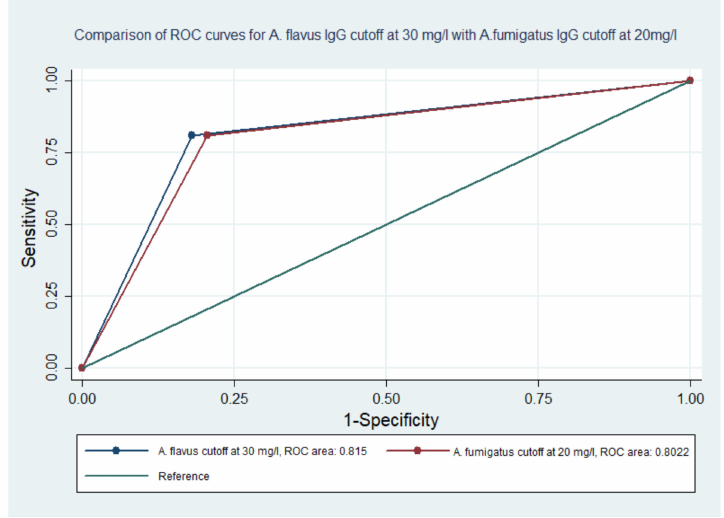
Figure 2. Comparison of ROC curves for A. flavus IgG at the cut-o ff of 30 mg / L and A. fumigatus IgG at 20 mg /